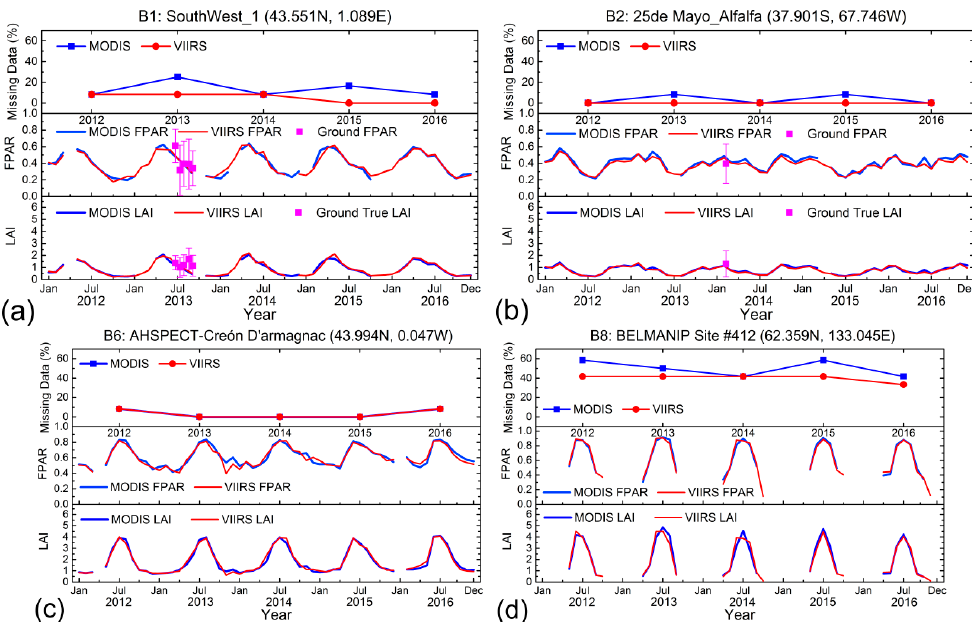
Figure 6. Temporal comparison of VIIRS and MODIS LAI/FPAR over four selected example sites. Monthly LAI and FPAR for the time period 2012–2016 are shown here. Red and blue lines indicate VIIRS and MODIS, respectively. The upper panel shows the missing data rate in each year and the following two panels show the seasonal variation of LAI/FPAR products with collected ground measurements. The error bar of the ground measurement was derived from the standard deviation of LAI/FPAR over the specified 3 km × 3 km region. Panel ( a – d ) are for grasses/cereal crops (B1), shrubs (B2), deciduous broadleaf forest (B6) and deciduous needleleaf forest (B8) cases, respectively.